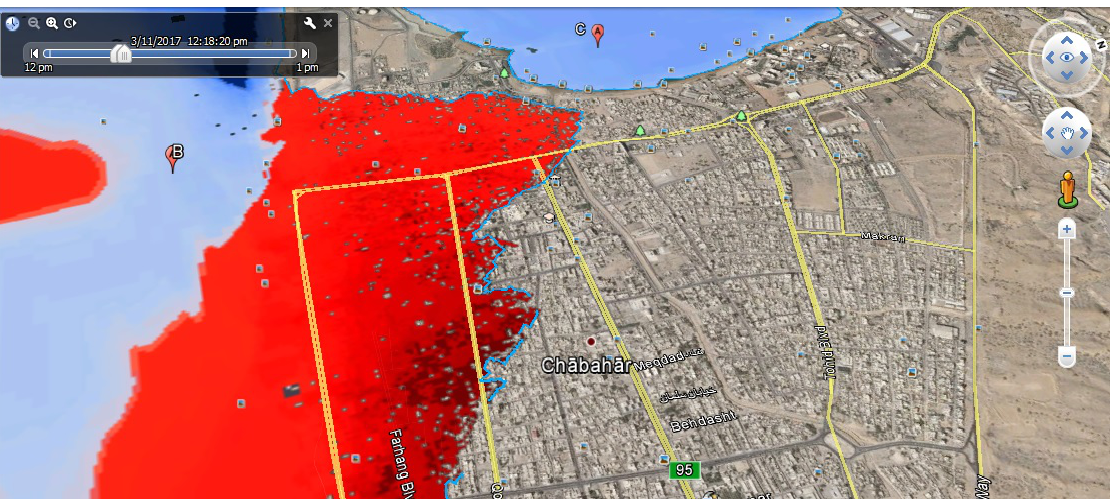
Figure 10. Tsunami waves reach to Chabahar Port during the tsunami simulation. This photo shows 18 minutes and 20 seconds after tsunami